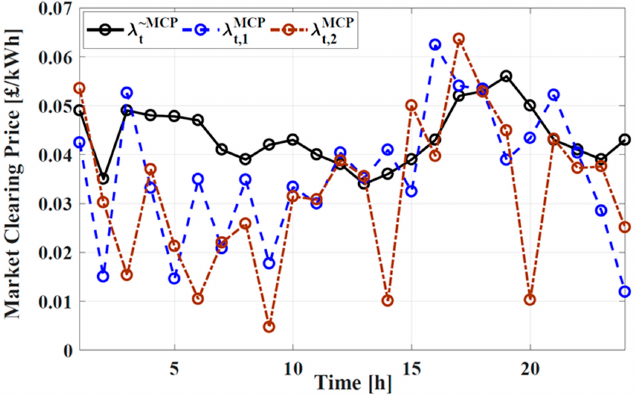
Figure 8. MCP during system daily performance . Figure 8. Market Clearing Price (MCP) during system daily